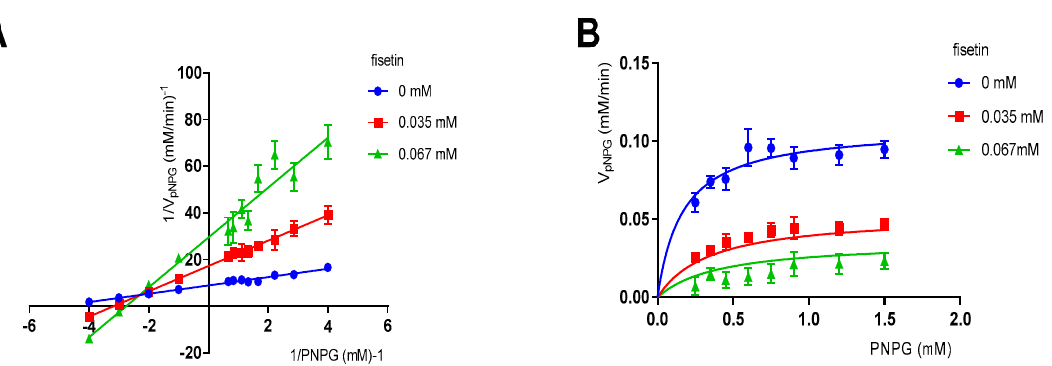
Figure 3. Enzymatic kinetic assay. ( A ) Lineweaver-Burke plot of the inhibition kinetics of α -glucosidase by fisetin. ( B ) Michaelis-Menten plot for fisetin in the presence of p-nitrophenyl- β -glucopyranoside (pNPG) at several concentrations for the determination of Ki.